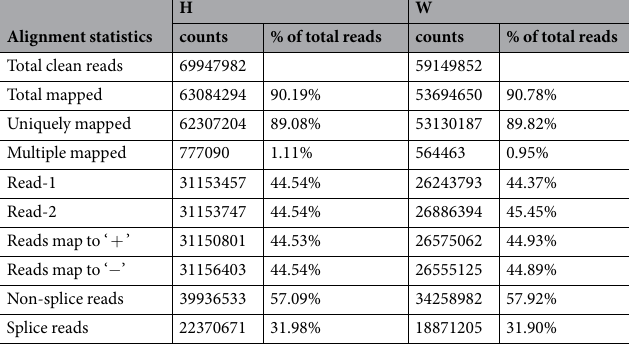
Table 1. Reads mapping